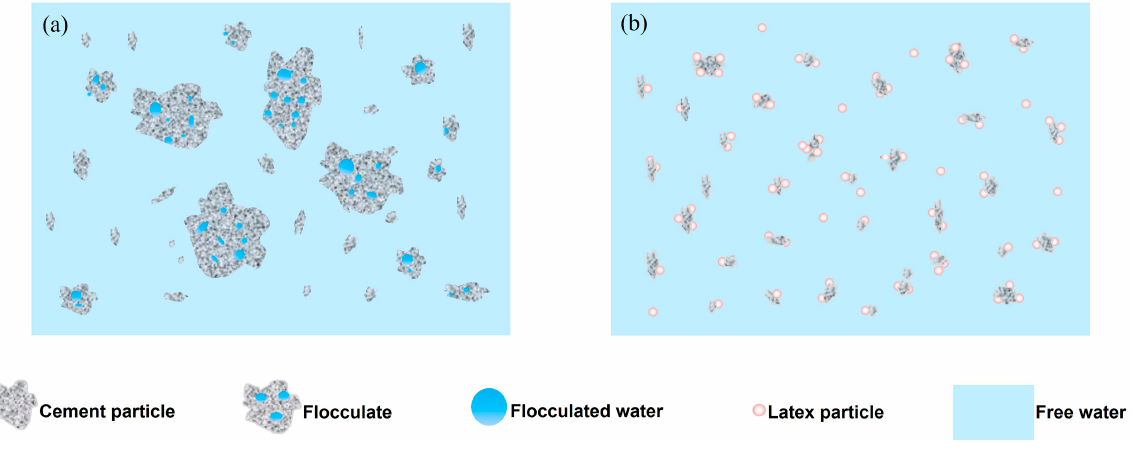
Figure 8. Schematic diagram of the influence of SISBR latex on cement paste; cement flocculation ( a ), the latex disassembled the cement flocculates ( b ).